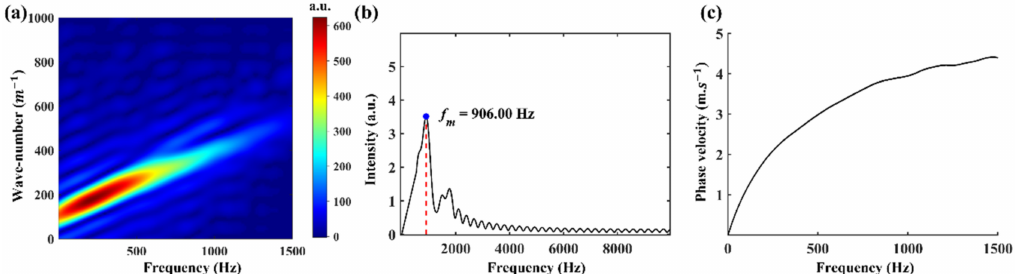
Figure 4. Wavenumber–frequency domain of elastic waves in homogeneous phantoms. ( a ) The local wavenumber–frequency domain map. ( b ) The intensity–frequency characteristic curve. ( c ) The phase velocity dispersion curve of the homogeneous